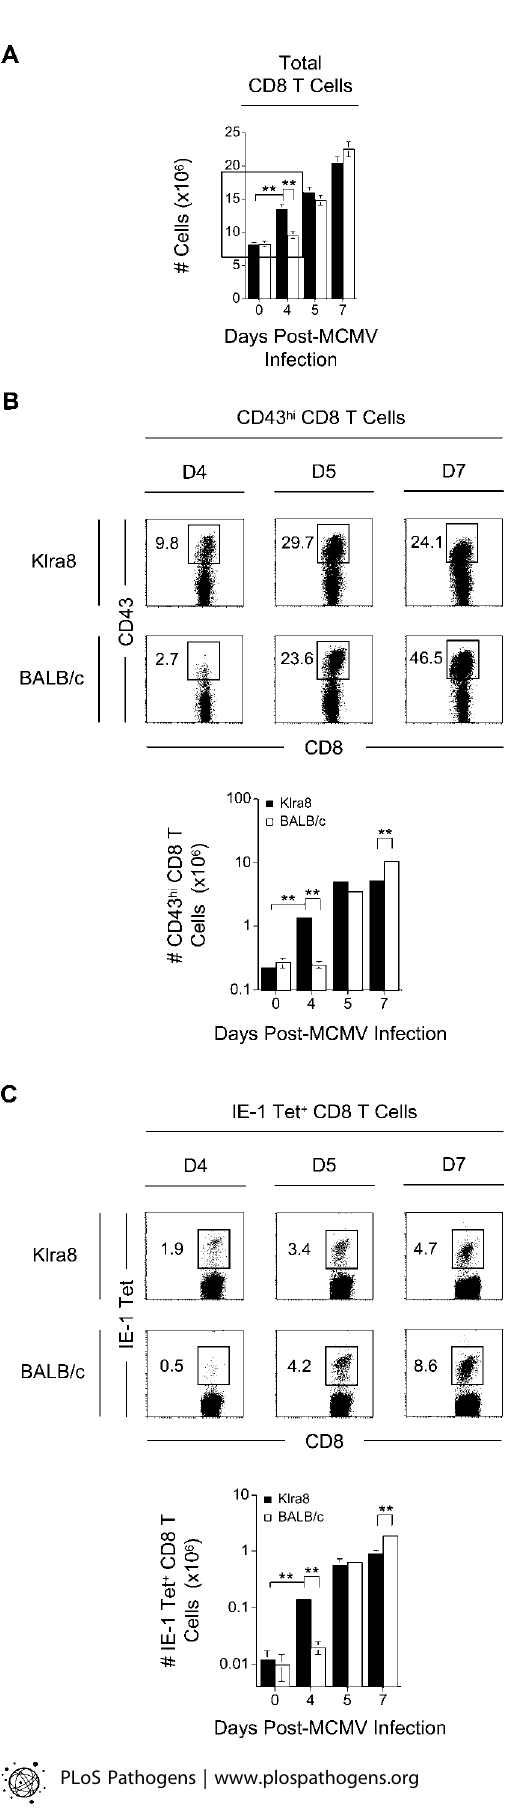
Figure 3. Kinetics of Antigen-Specific CD8 T Cells Expansion in Klra8 and BALB/c Mice in Response to MCMV Infection Splenic leukocytes were isolated from Klra8 and BALB/c mice on days 0, 4, 5, and 7 post–MCMV infection and analyzed for (A) total numbers of CD8 T cells (TCR b þ CD8 a þ ), (B) CD43 expression on the total CD8 T cell population, and (C) binding of IE-1-loaded MHC class I tetramers on the total CD8 T cell population. CD43 expression on CD8 T cells and IE-1- loaded MHC class I tetramer binding to CD8 T cells is shown for one representative animal from groups of three mice for days 4, 5, and 7 post–MCMV infection. Numbers in dot plots represent percent CD43 hi or percent IE-1 tetramer þ CD8 T cells within the total CD8 T cell population. Graphs represent the total numbers (in millions) of CD8 T cells, CD43 hi CD8 T cells, or IE-1 tetramer þ CD8 T cells. Results are expressed as mean 6 SD of three mice per group. One experiment representative of four for (A–C) is shown. ** p (cid:3) 0.01.